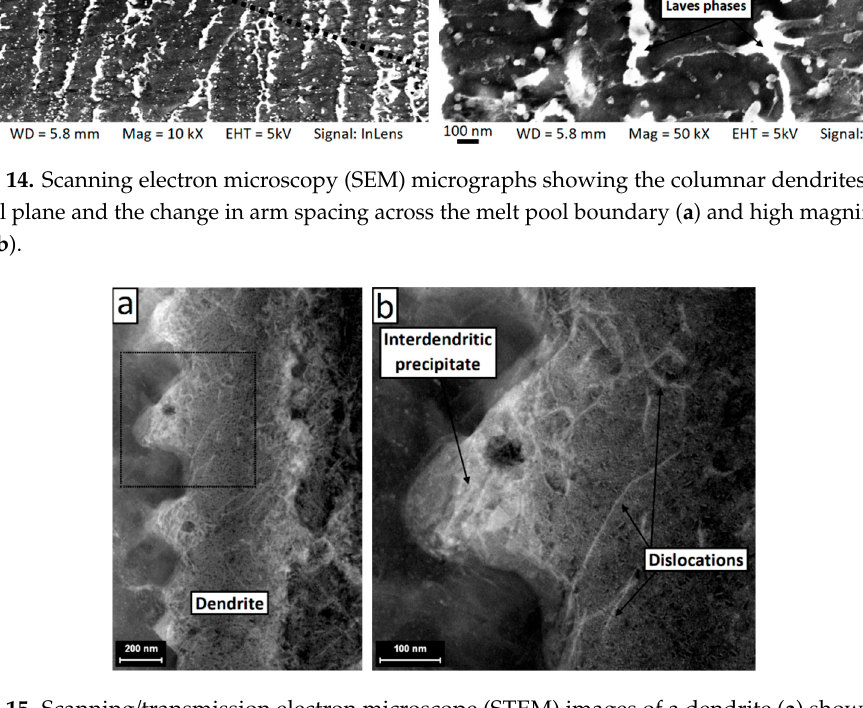
Figure 15. Scanning/transmission electron microscope (STEM) images of a dendrite ( a ) showing the Figure 15. Scanning / transmission electron microscope (STEM) images of a dendrite ( a ) showing the